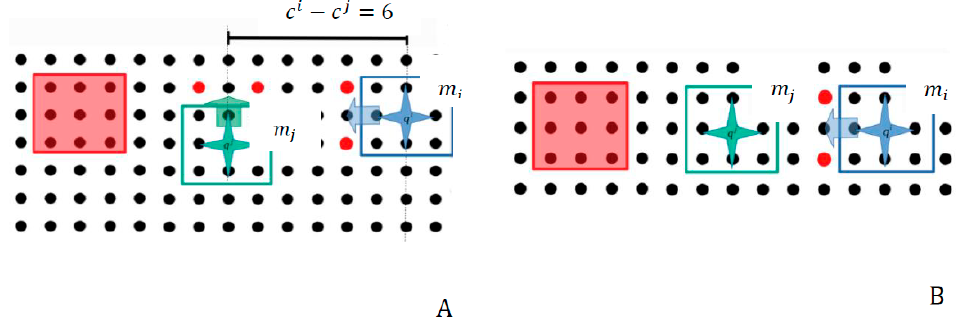
Figure 20. Best Configuration Choice for collision avoidance. ( A ) the sufficient distance between the m i and m j ; ( B ) the sufficiency of their distance is certified.